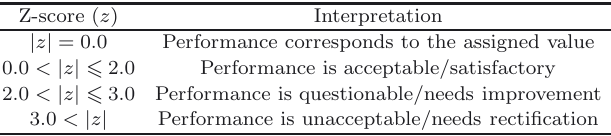
Table 1. Z-score interpretation table. Z-score ( z ) Interpretation | z | = 0 .